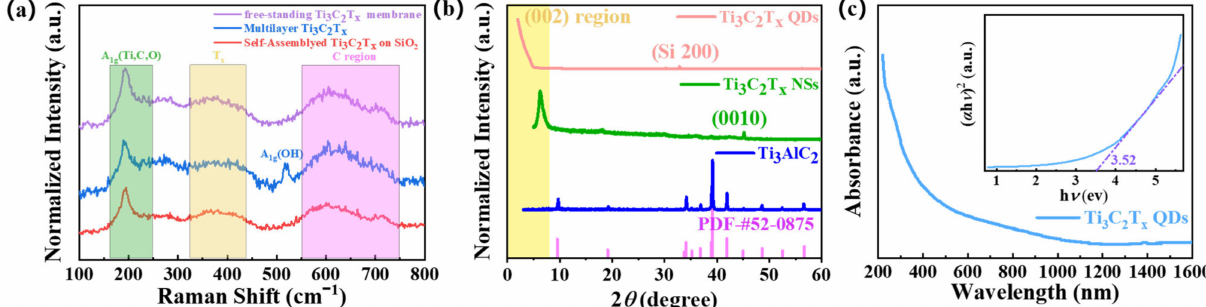
Figure 4. ( a ) Raman spectra of Ti 3 C 2 T x NSs with various states. ( b ) XRD patterns of Ti 3 AlC 2 MAX, Ti 3 C 2 T x NSs, and Ti 3 C 2 T x QDs deposited on a silicon wafer, respectively. ( c ) UV–vis–NIR absorption spectrum of Ti 3 C 2 T x QDs; the inset is the value of the bandgap fitted by using a Tauc